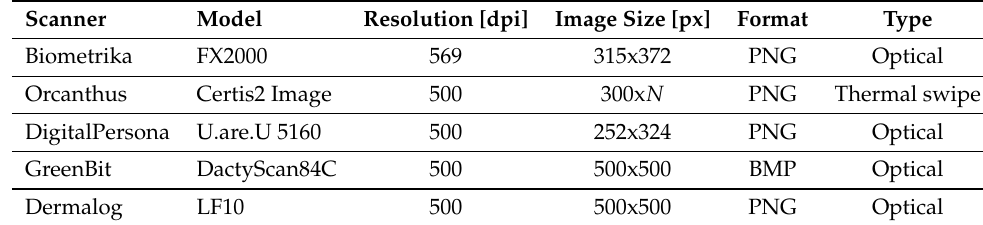
Table 2. Device characteristics for LivDet 2013, 2019, and 2021 datasets.